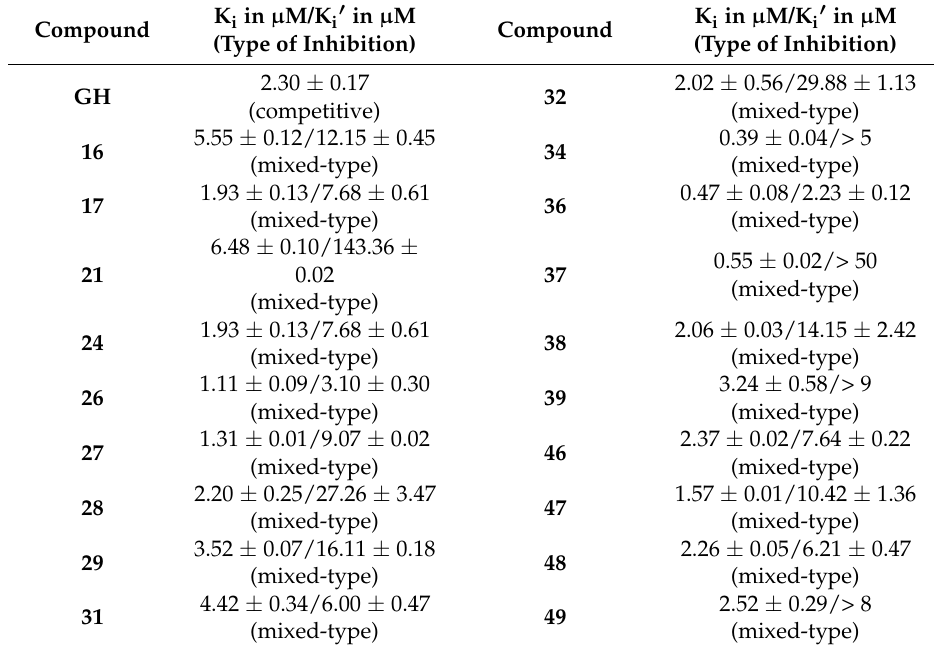
Table 1. Significant results of the BChE inhibition assay. Inhibitory constants (K i and K i (cid:48) in µ M), determined using Ellman’s assays employing butyrylcholinesterase (BChE, equine serum) with galantamine hydrobromide ( GH ) as standard.